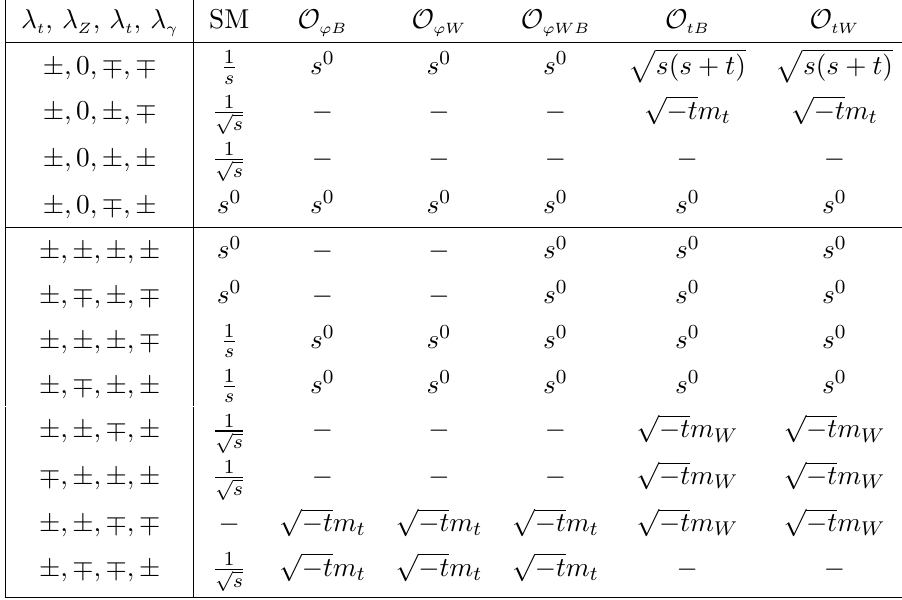
t v ) for tZ t(cid:13) scattering. (cid:24) (cid:0) (cid:29) ! ’ indicate any combination of ; . See (cid:3) (cid:6) (cid:7)